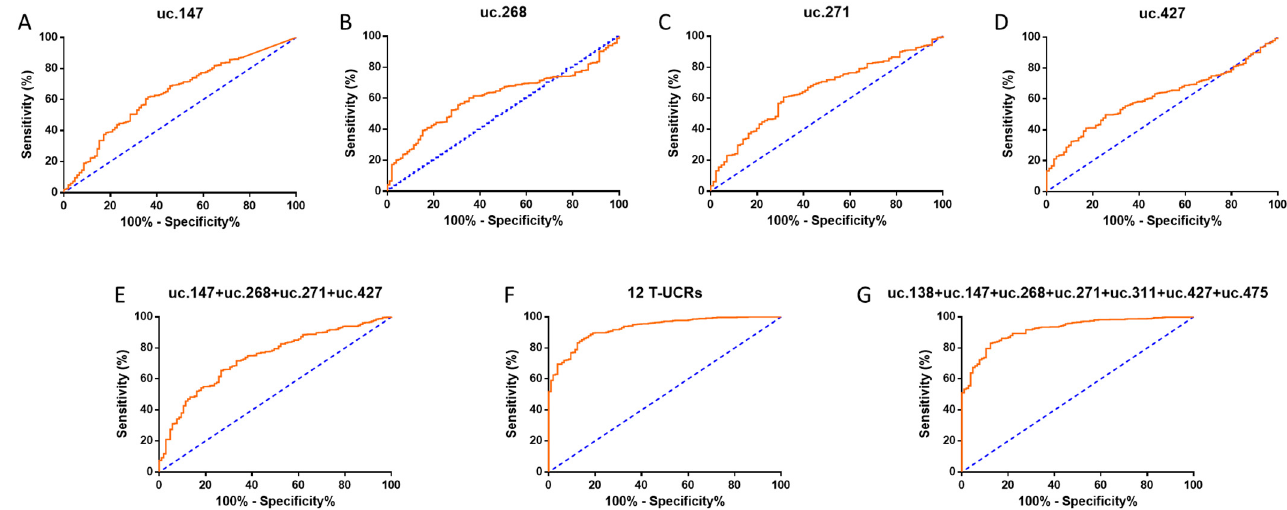
Figure 2. Individual and combined receiver operating characteristic (ROC) curves from T-UCRs, indicating diagnostic potential panels. ( A – D ) BC prognostics accuracy calculated for uc.147 TCGA ( A ), uc.268 TCGA ( B ), uc.271 TCGA ( C ), and uc.427 TCGA ( D ). ( E – G ) Combined ROC curves of uc.147 + uc.268 + uc.271 + uc.427 ( E ), all 12 T-UCRs ( F ), and uc.138 + uc.147 + uc.268 + uc.271 + 311 + uc.427 + uc.475 ( G ). ROC curves calculated based on relative quantification (RQ) values. All p values are under 0.05.